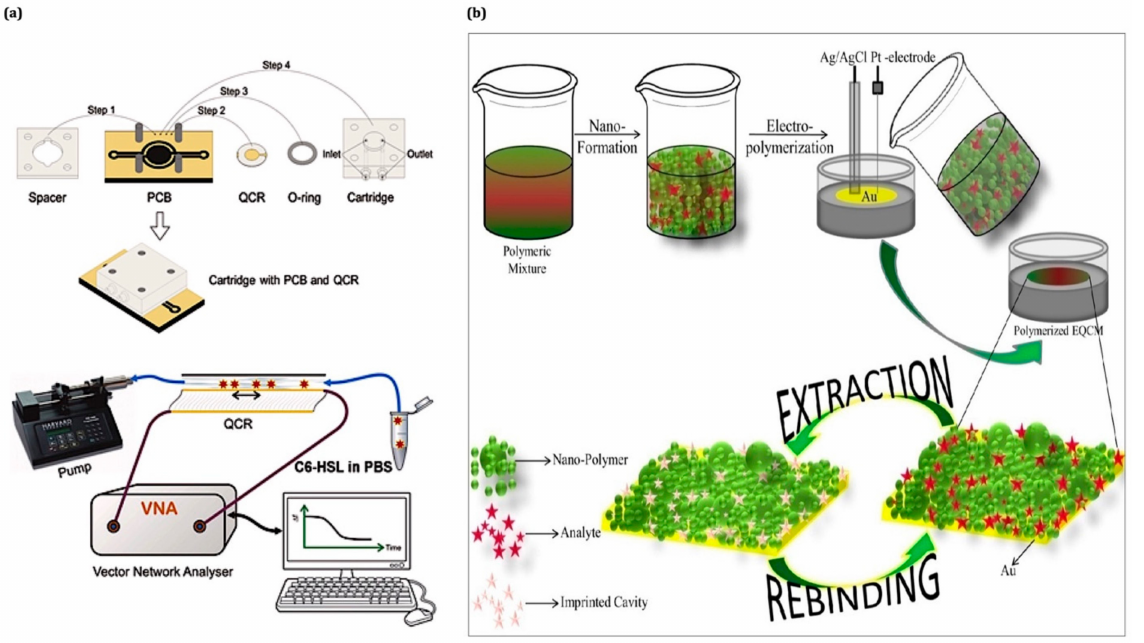
Figure 6. ( a ) QCR experiment system. Reprinted with permission from ref. [158]. Copyright 2020 Elsevier; ( b ) schematic representation of an LP-15-imprinted EQCM sensor. Reprinted with permission from ref. [159]. Copyright 2019